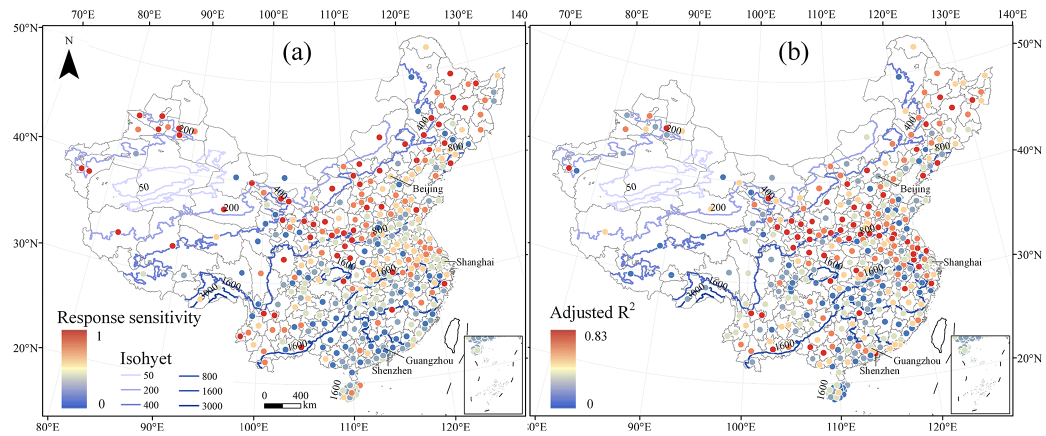
Figure 6. Spatial distribution of the response sensitivity (a) and adjusted R 2 (b) in multiple linear regression. The isohyets show the 2017 annual